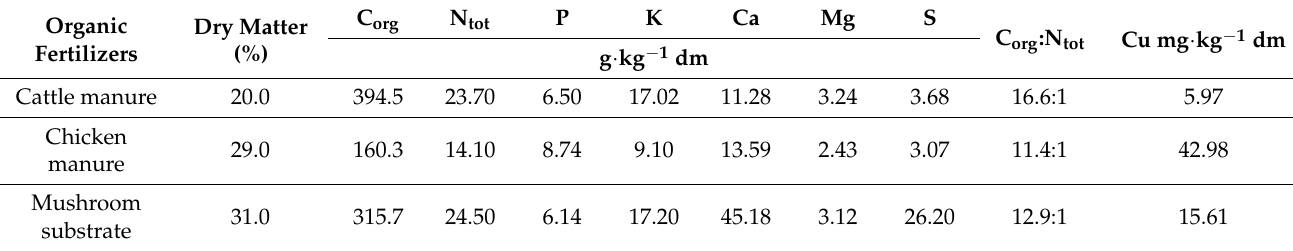
Table 1. Chemical composition of organic fertilizers used in pot